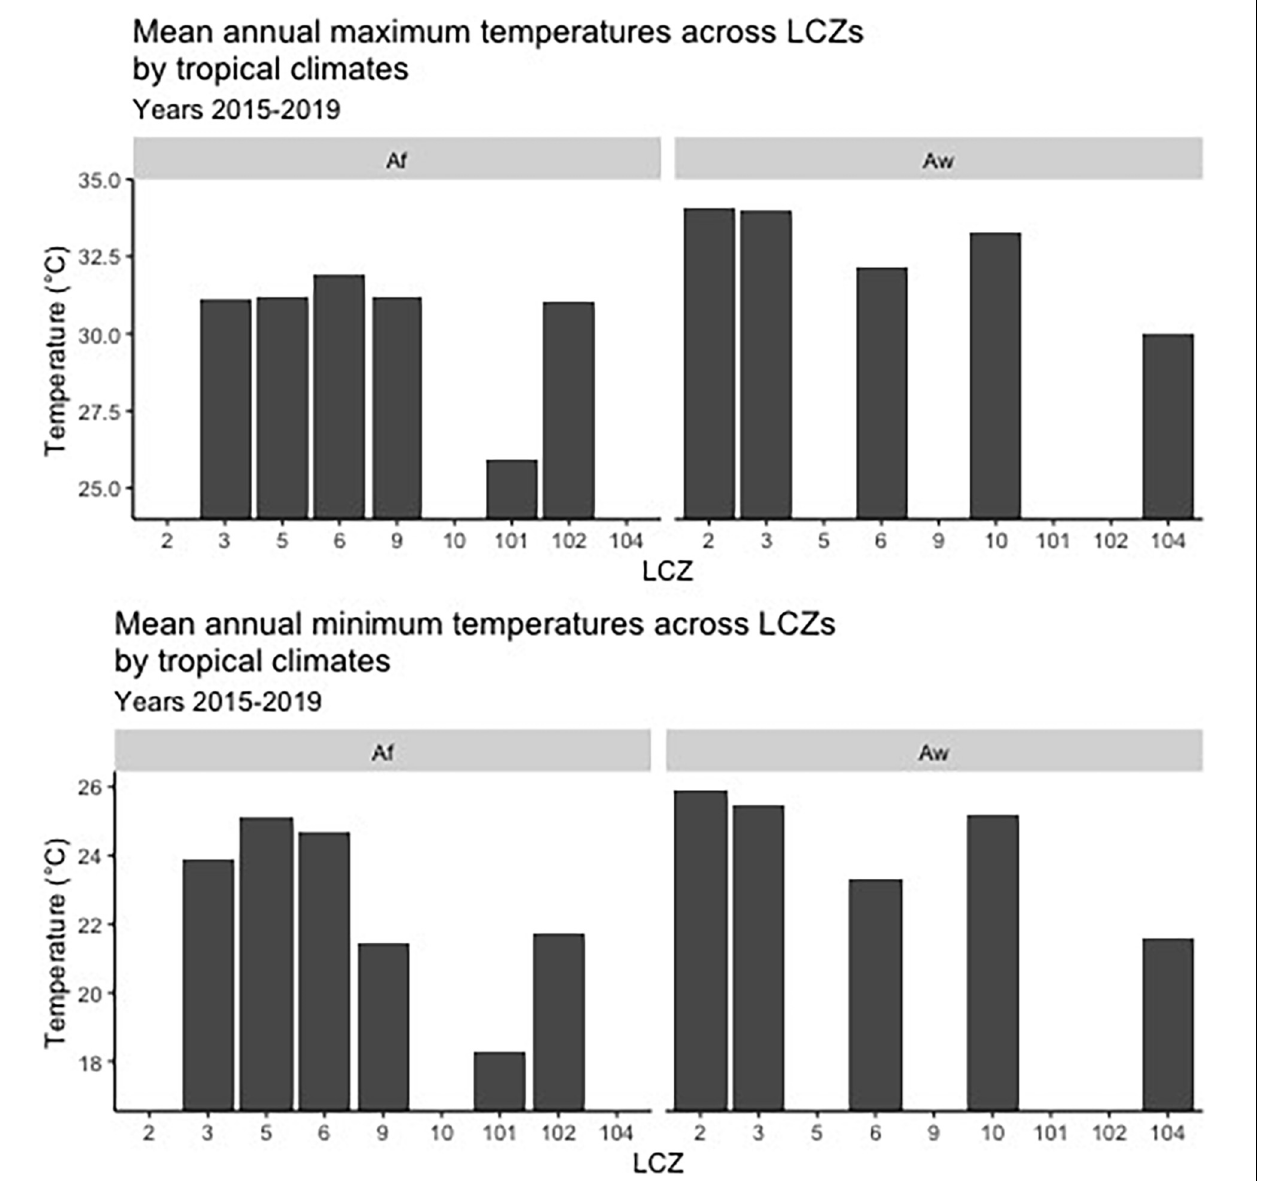
FIGURE 14 | Mean annual maximum and minimum temperatures across LCZs in tropical climates. Local climate zones values 1 = Compact high-rise, 2 = Compact mid-rise, 3 = Compact low-rise, 4 = Open high-rise, 5 = Open mid-rise, 6 = Open low-rise, 7 = Lightweight low-rise, 8 = Large low-rise, 9 = Spare built, 10 = Heavy Industry, 101 = Dense trees, 102 = Scattered trees, 103 = Bush, scrub, 104 = Low plants, 105 = Bare rock or paved, 106 = Bare soil or sand, 107 = Water. Data sources: NOAA, GHCN and